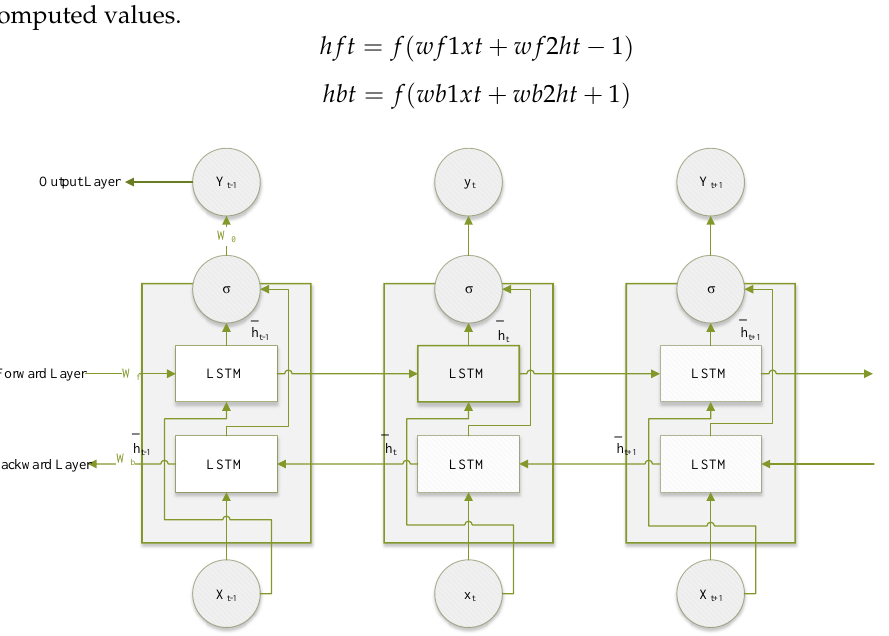
Figure 6. Graphical representation of Bi-LSTM.